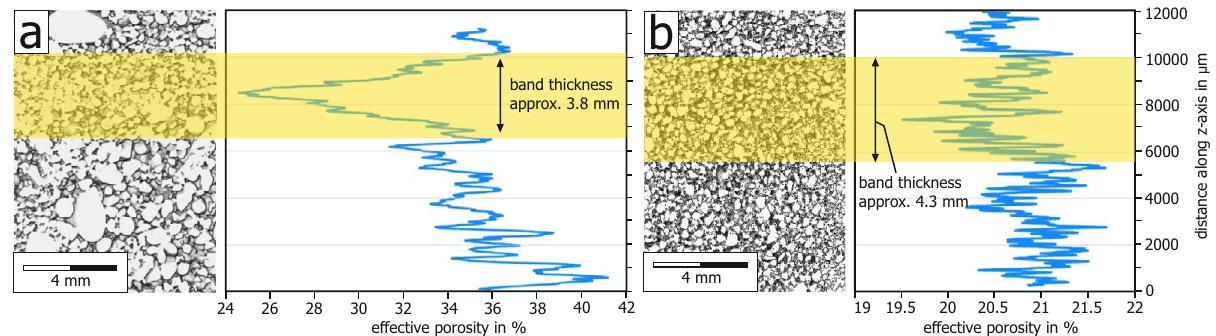
Fig. 6 μ -CT analysis of disaggregation bands. a Natural band from the Freden outcrop (see Fig. 1 for location). The μ -CT analysis indicates a strong decrease in porosity within the band. b μ -CT analysis of an experimental disaggregation band. A porosity reduction also occurs across this band, but is much less pronounced than in the natural example. The porosity loss in both cases is the result of the shear-induced grain-fabric reorganization. The lower loss in porosity in case of the experimental band is likely due to the lack of a con fi ning pressure. The μ -CT results support the thin-section